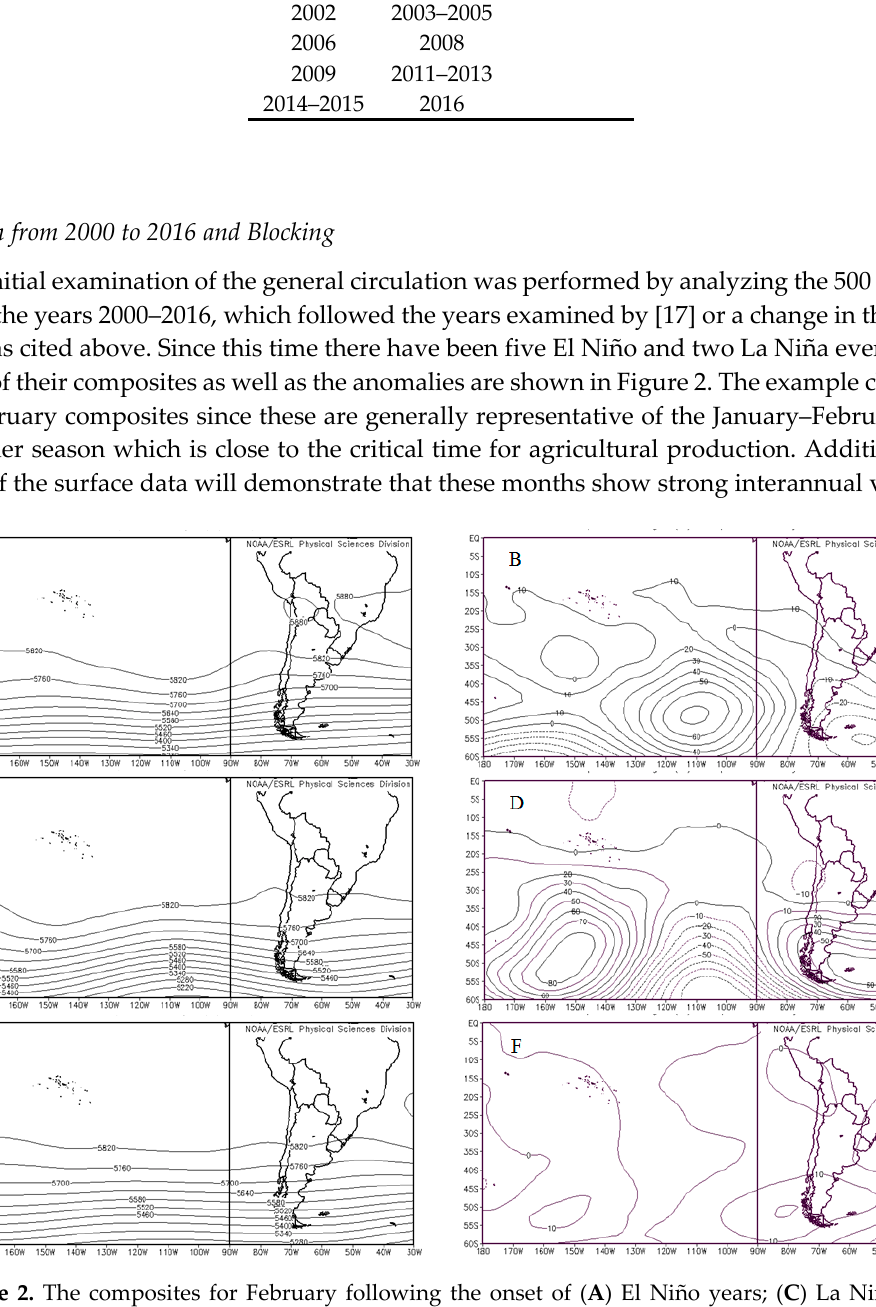
Figure 2. The composites for February following the onset of ( A ) El Niño years; ( C ) La Niña; ( E ) Neutral years since 2000; and ( B , D ); and ( F ) their differences from the 1981–2010 climatology, respectively. The contour intervals are ( A , C , E ) 60 dam, and ( B , D , F ) 10